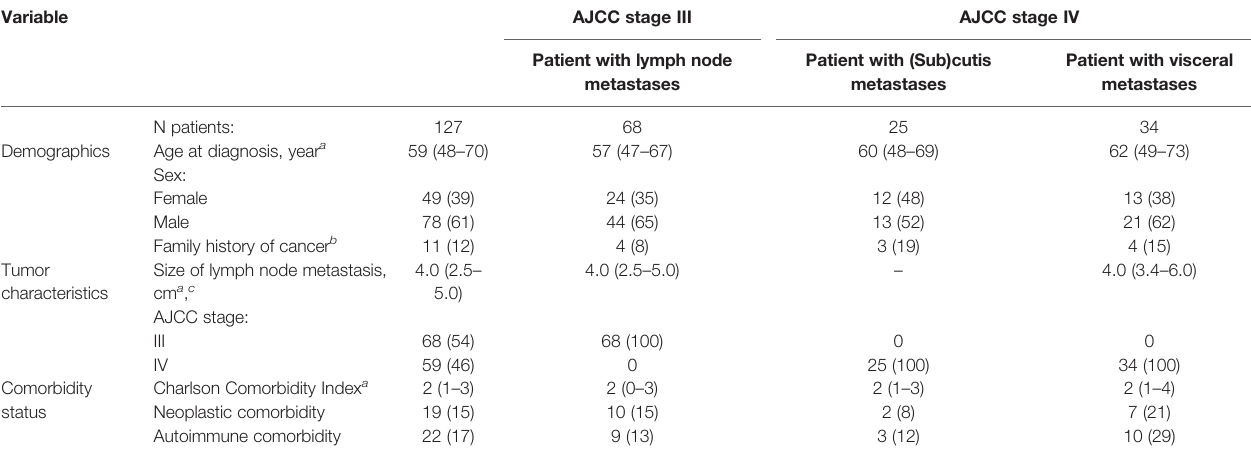
TABLE 2 | Patient and tumor